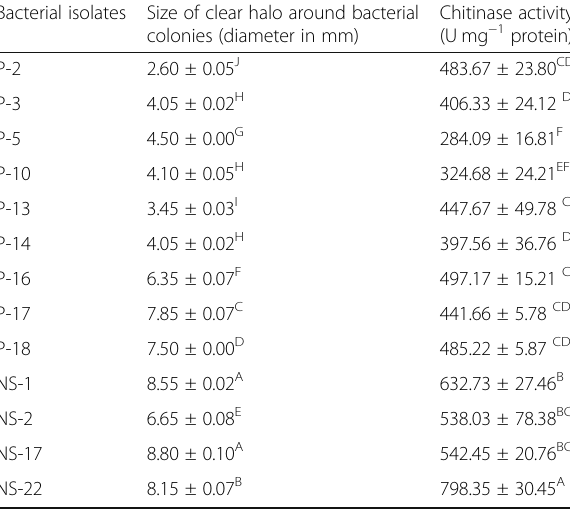
Table 2 In vitro antagonistic activities of the promising chitinolytic bacterial isolates against pigeon pea wilt pathogen ( Fusarium udum Table 1 Zone of chitin hydrolysis and chitinase activity exhibited by the selected efficient rhizobacterial isolates Bacterial isolates Size of clear halo around bacterial Chitinase activity colonies (diameter in mm) (U mg − 1 protein)